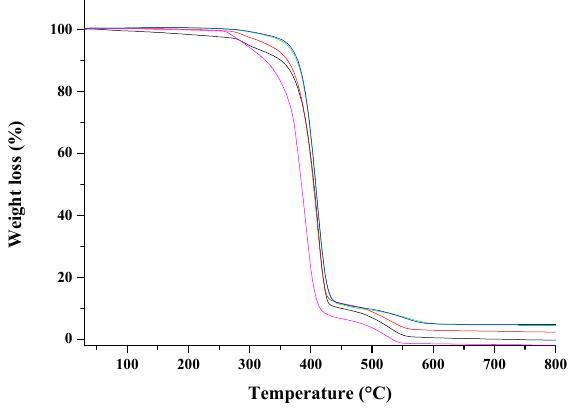
Figure 4. TGA of: PCL ( Figure 4. TGA of: PCL ( ), undeformed nanocomposite ( ), drawn at λ = 3 ( ), drawn at λ = 4 ), drawn at λ = 3 ( Figure 2. TGA/DTG of: HNTs ( ), Lysozyme ( Figure 3. ATR spectra of ( A ): Undeformed nanocomposite ( ), drawn at λ = 3 ( ), drawn at λ = 4 Figure 2. TGA/DTG of: HNTs ( ), Lysozyme ( ), nano ‐ hybrid HNTs/Lysozyme ( ). Figure 4. TGA of: PCL ( ), undeformed nanocomposite ( ), drawn at λ = 3 ( ), drawn at λ = 4 Figure 2. TGA/DTG of: HNTs ( ), Lysozyme ( ), nano ‐ hybrid HNTs/Lysozyme ( ( ), and drawn at λ = 5 ( ). ( ), and drawn at λ = 5 ( ). Table 1. Thermal data for all nanocomposites and unfilled PCL, evaluated from TGA. Table 1. Thermal data for all nanocomposites and unfilled PCL, evaluated from TGA.